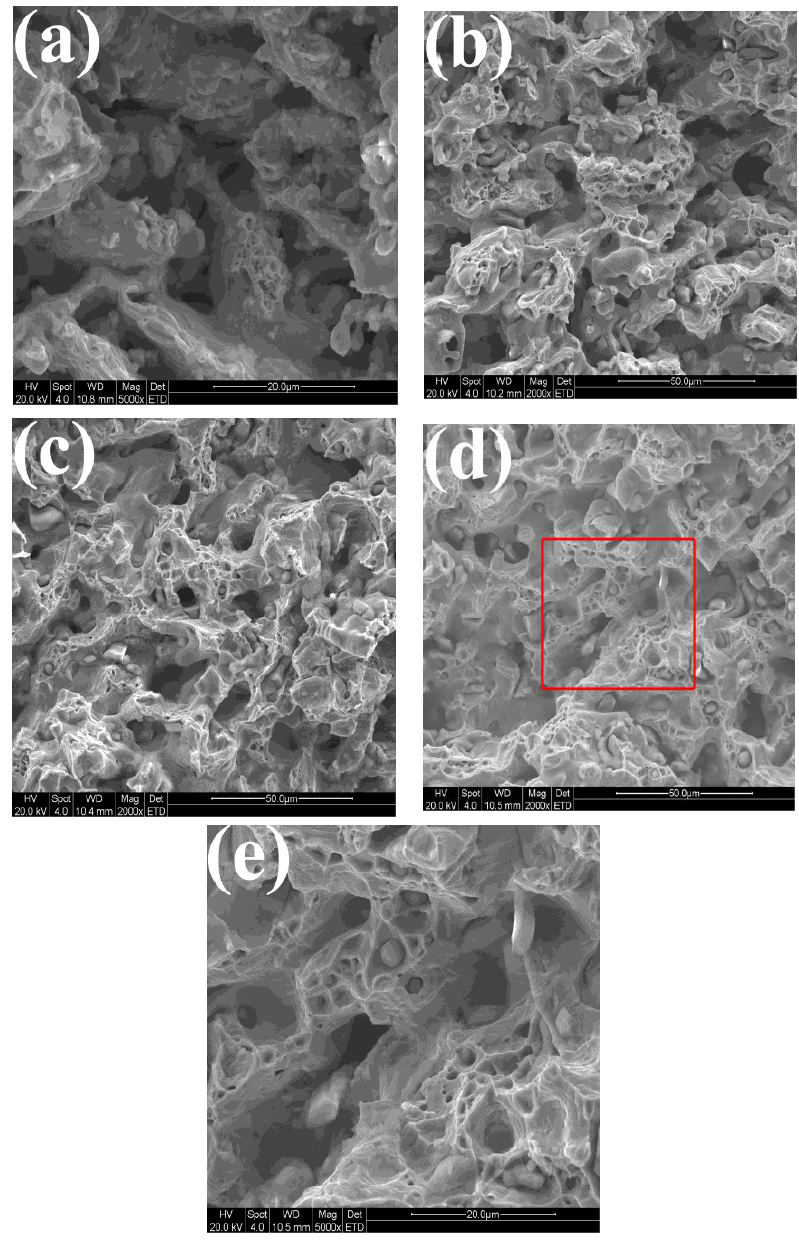
Figure 15. Fractography of the MM Fe-Mn-Si compacts sintered at 1200 °C for different isothermal holding times: ( a ) no isothermal holding; ( b ) 1 h; ( c ) 2 h; ( d ) 3 h; ( e ) enlarged area in ( d ).